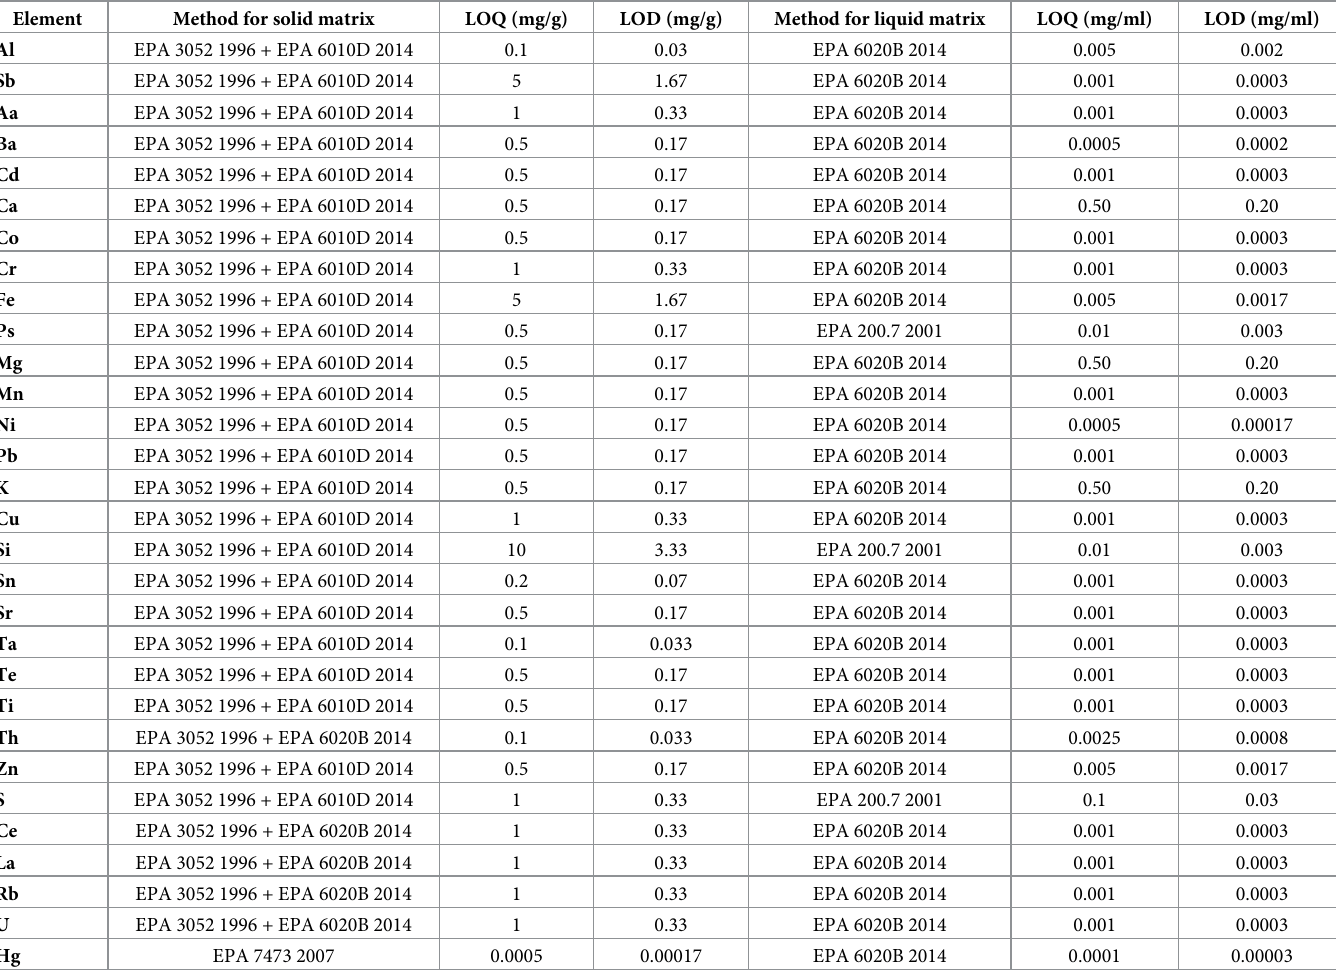
Table 1. Method of element analysis for the solid and liquid matrices with the relative quantification limit (LOQ) and detection limit (LOD). Element Method for solid